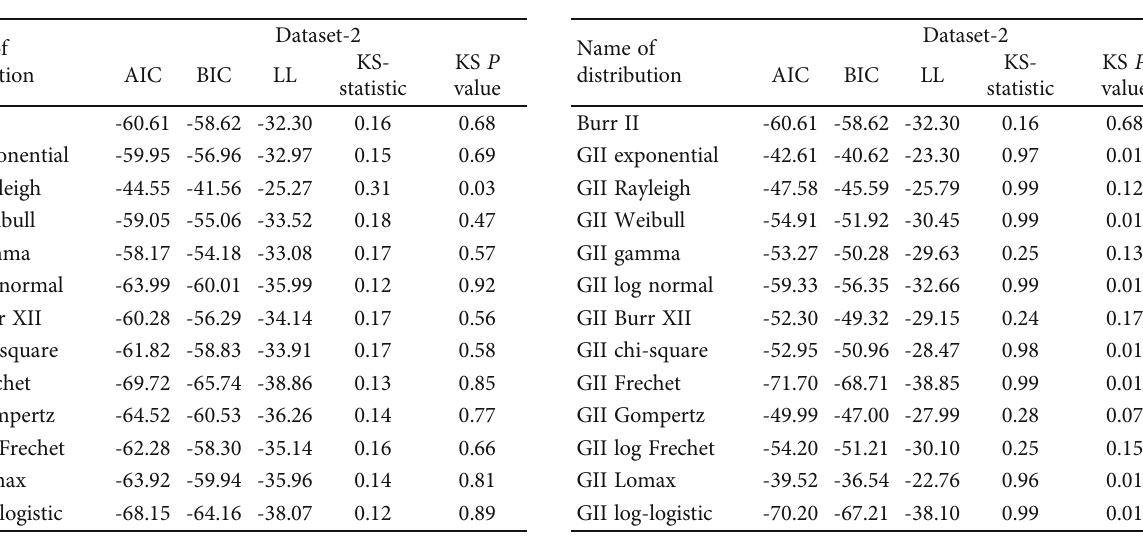
Table 24: Comparison of BT-IID with class of GGIDs using